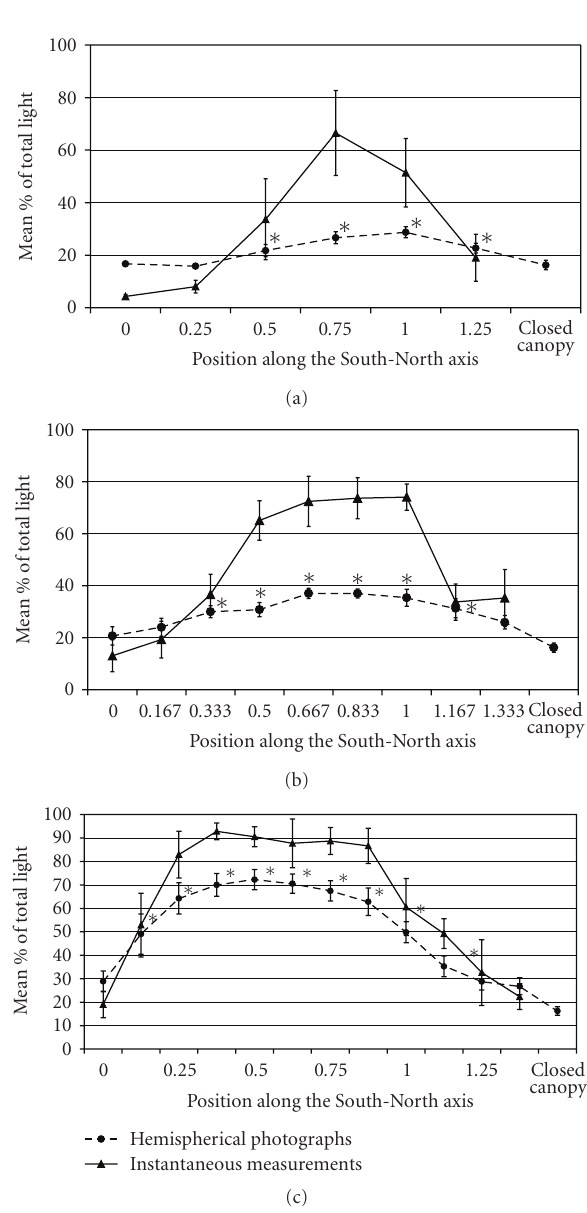
Figure 2: Mean percentage of total light relative to open conditions at di ff erent positions along the north-south axis of (a) small gaps ( D/H ratio ≤ 0.5, (b) medium gaps ( D/H ratio 1 ± 0 . 25), and (c) large gaps ( D/H ratio ≥ 1.5). For hemispherical photographs (circles), positions with an asterisk ( ∗ ) have significantly higher light levels than under closed forest canopy (Dunnett’s test). Values in brackets represent standard